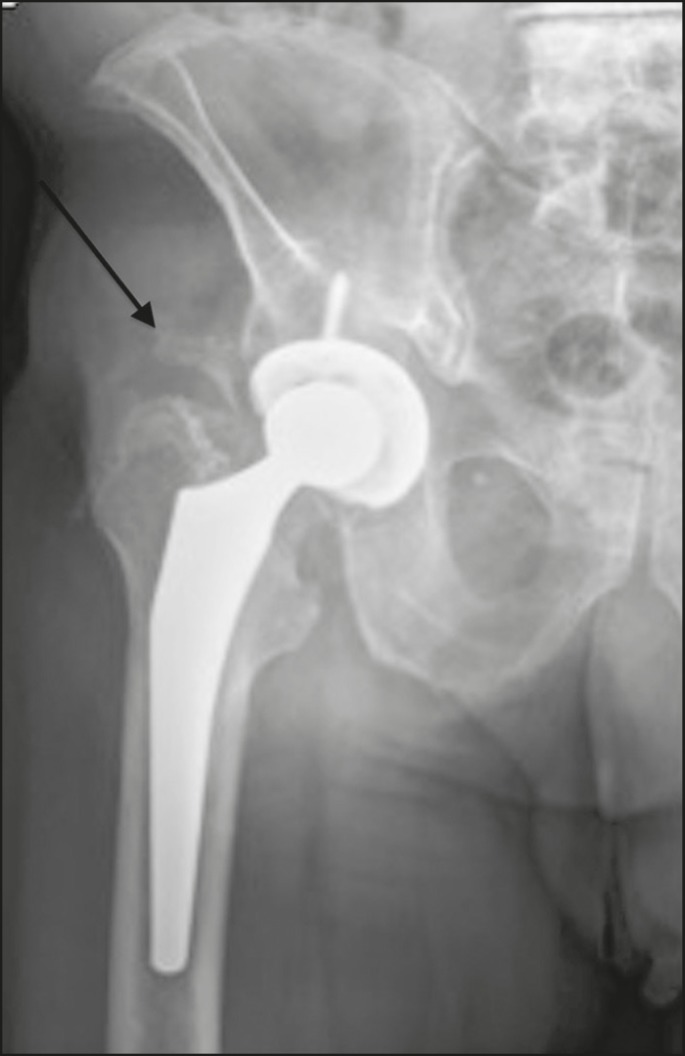
Total right hip arthroplasty in which the prosthesis had an acetabular component with screw fixation and an intramedullary femoral stem, with no signs of loosening or material failure. Grade II peritrochanteric heterotopic ossifications on the right (arrow).